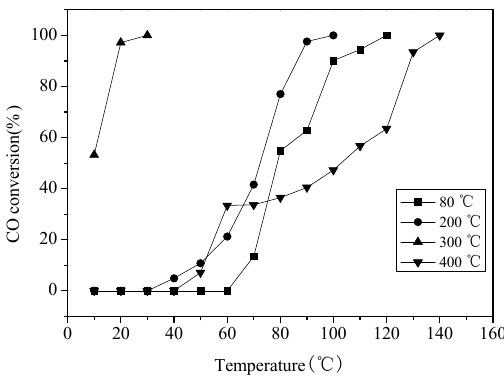
Figure 7. Catalytic activities of Au/Bi 2 WO 6 ‐ 400 (Au 1.30 wt %) calcined at different temperatures.